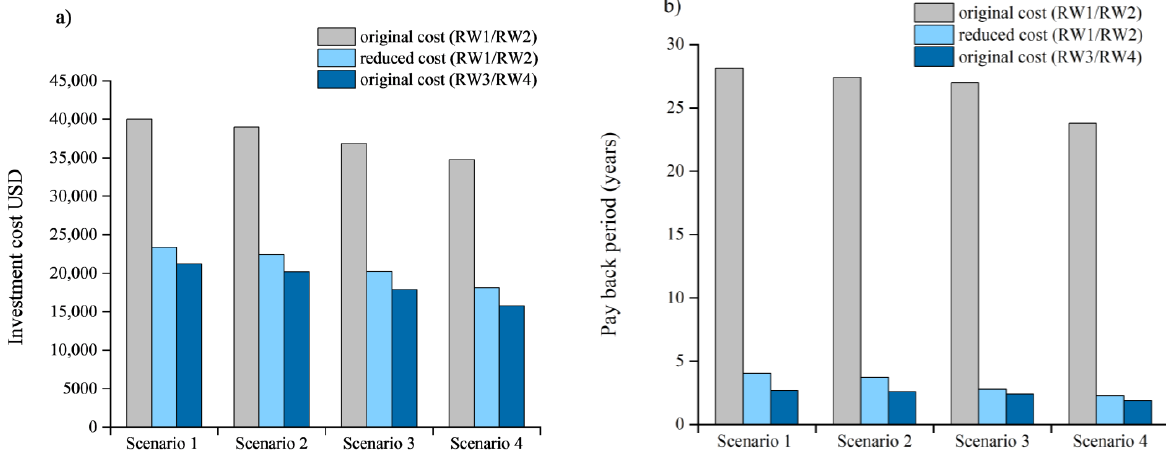
Figure 4. Effect of reducing the IPRS growout raceway construction investment cost by 66% on ( a